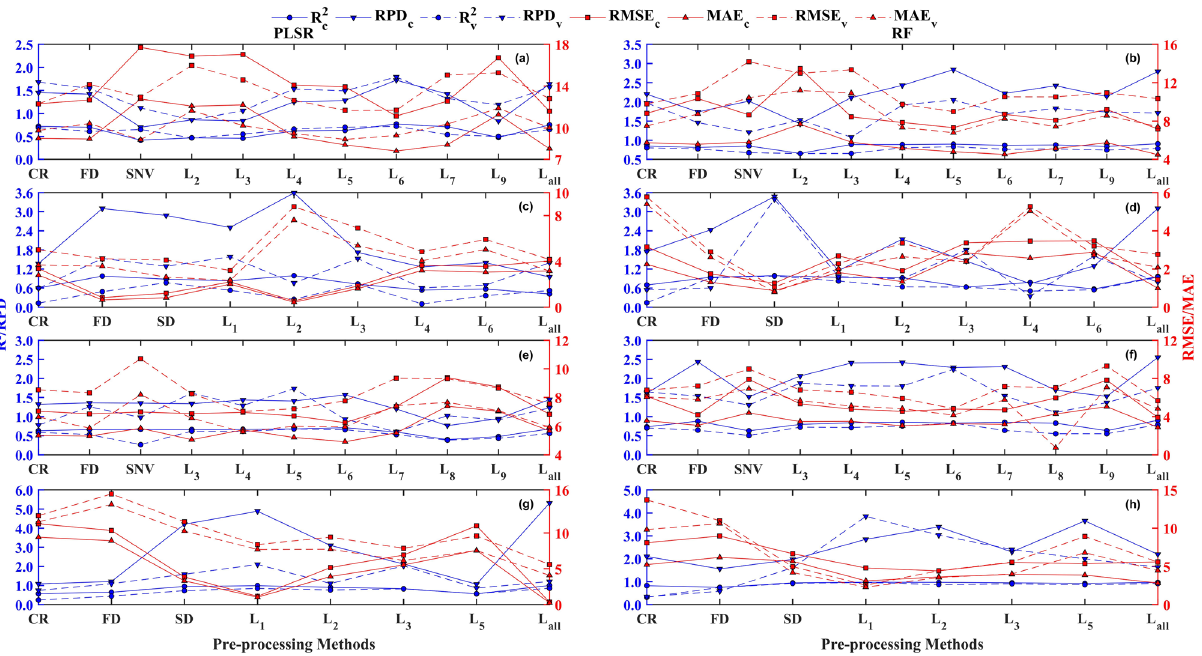
Figure 6. Comparing the performance of calibrating Zn concentration corrected by natural logarithmic transformation based on different spectral reflectance transformation methods using RF and PLSR at four conditions concerning the entire group, clean group, low pollution group, and moderate pollution group. ( a , b ): entire samples group, ( c , d ): clean group, ( e , f ): low pollution group, and ( g , h ): moderate pollution group.